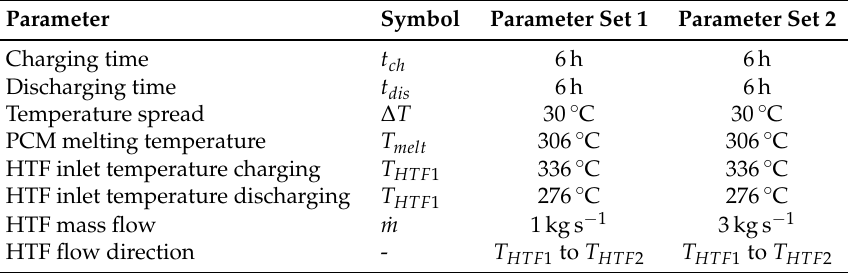
Table 1. Parameter